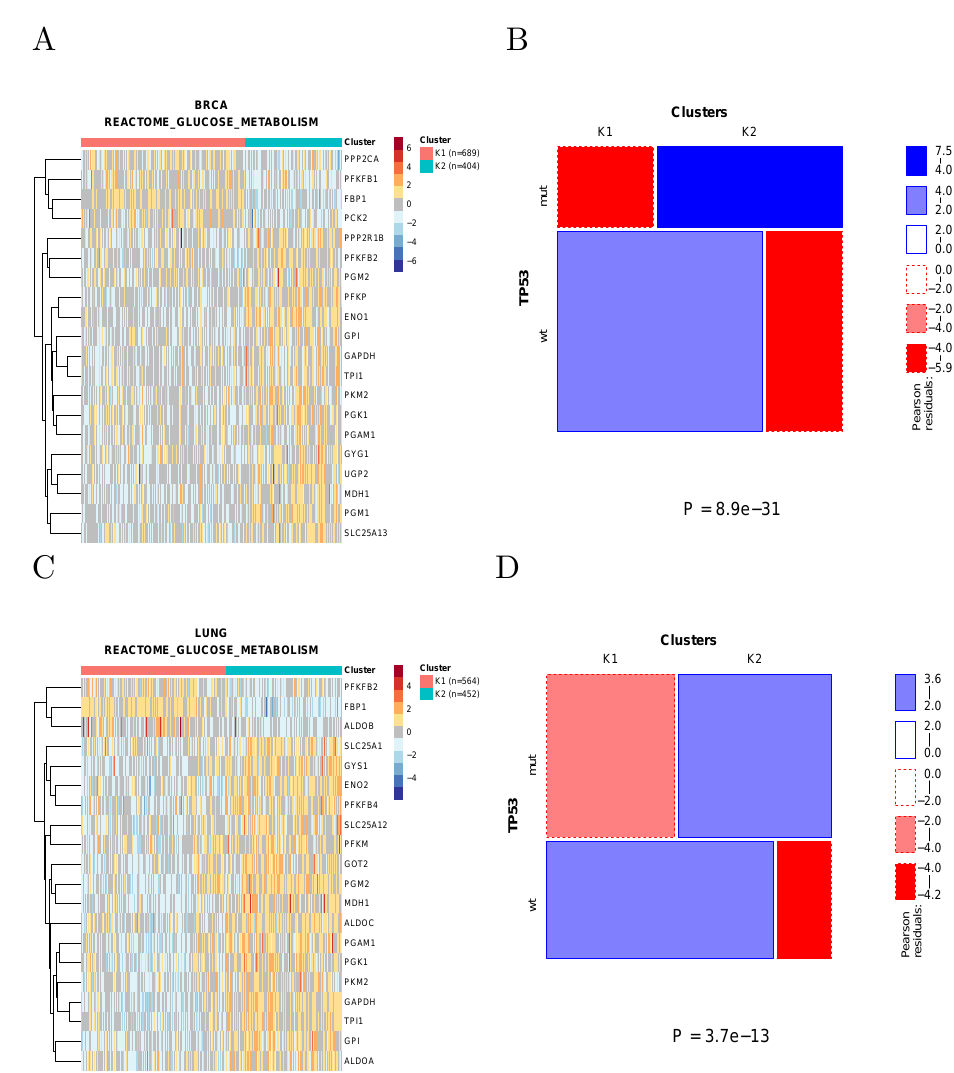
Figure 5. ( A ) Clustering of breast cancer samples using the genes associated with glucose metabolism according to REACTOME. Cluster K2 shows upregulation of Warburg effect genes, such as GAPDH, PGK1, and PKM2. ( B ) The prevalence of TP53-mutated samples is significantly higher in cluster K2. ( C , D ) Same for lung cancer